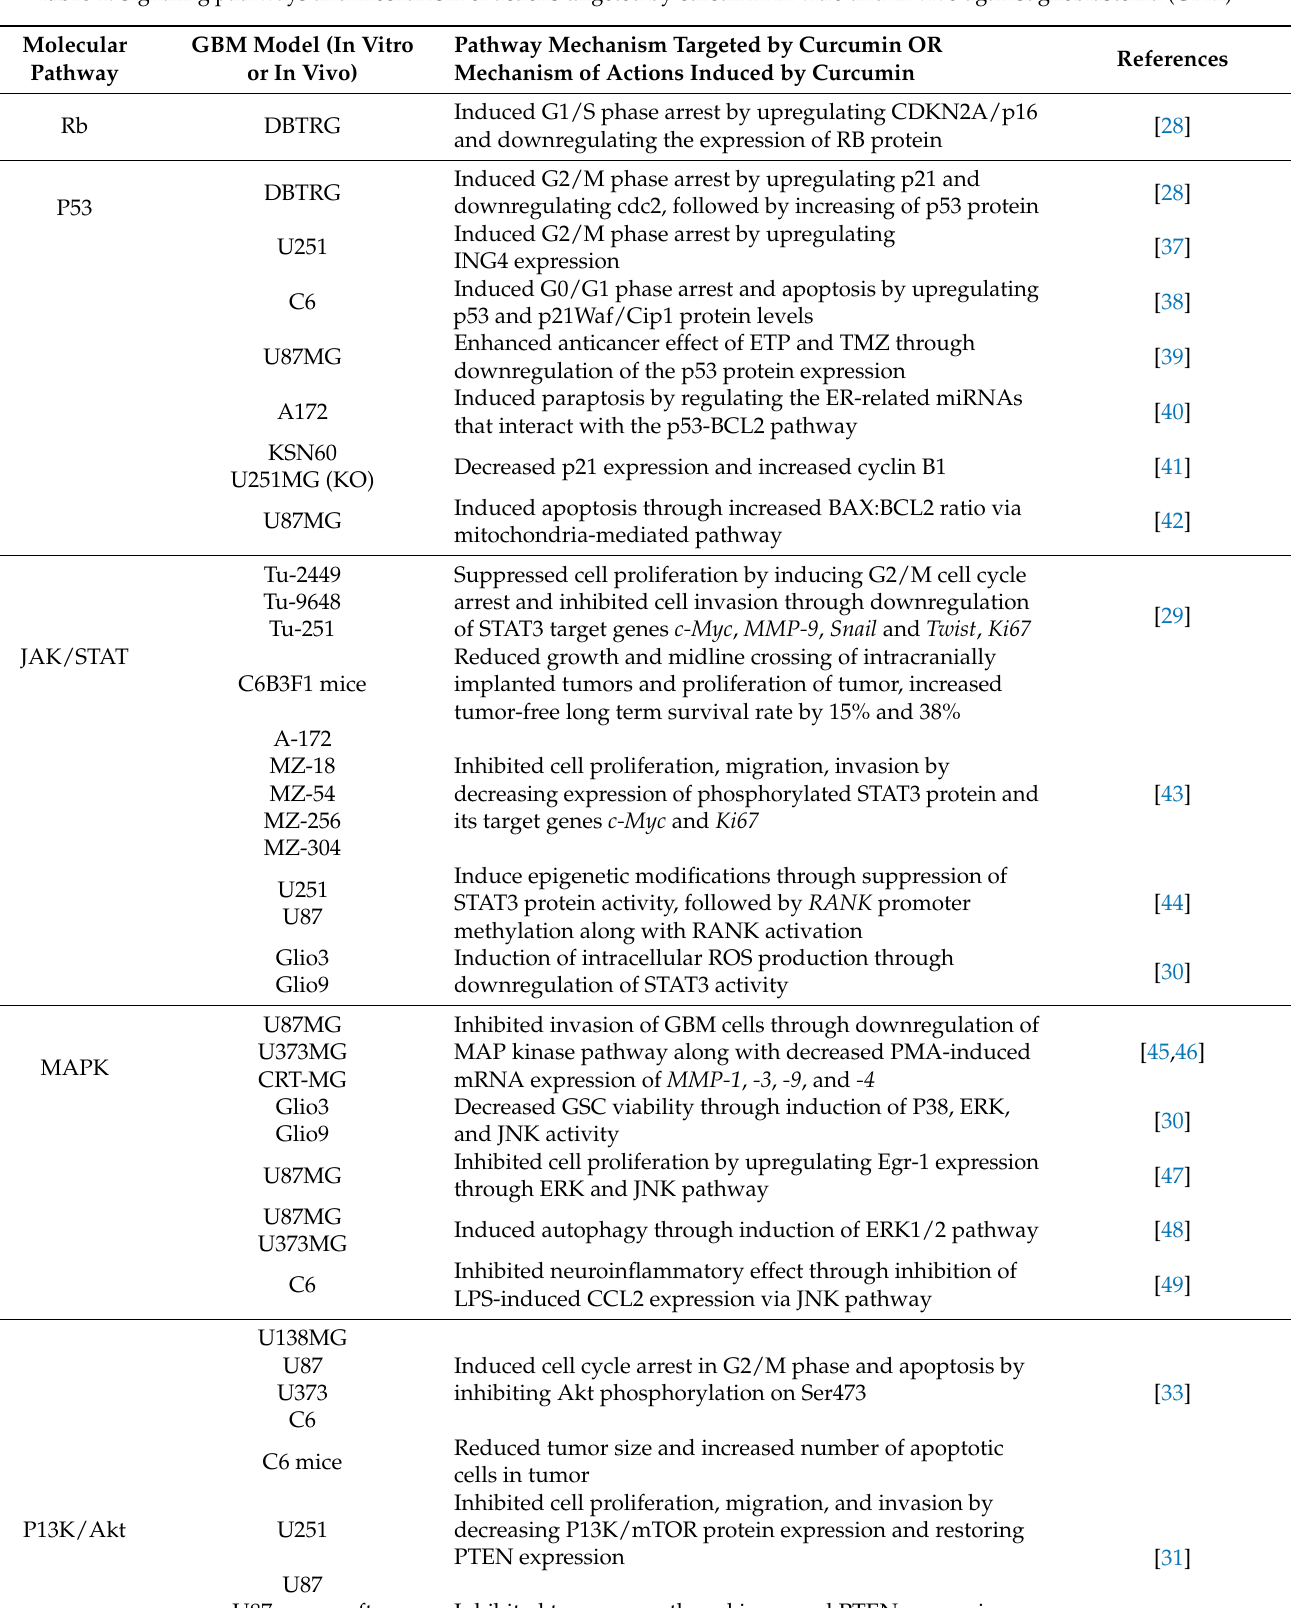
Table 1. Signaling pathways and mechanism of actions targeted by curcumin in vitro and in vivo against glioblastoma (GBM).